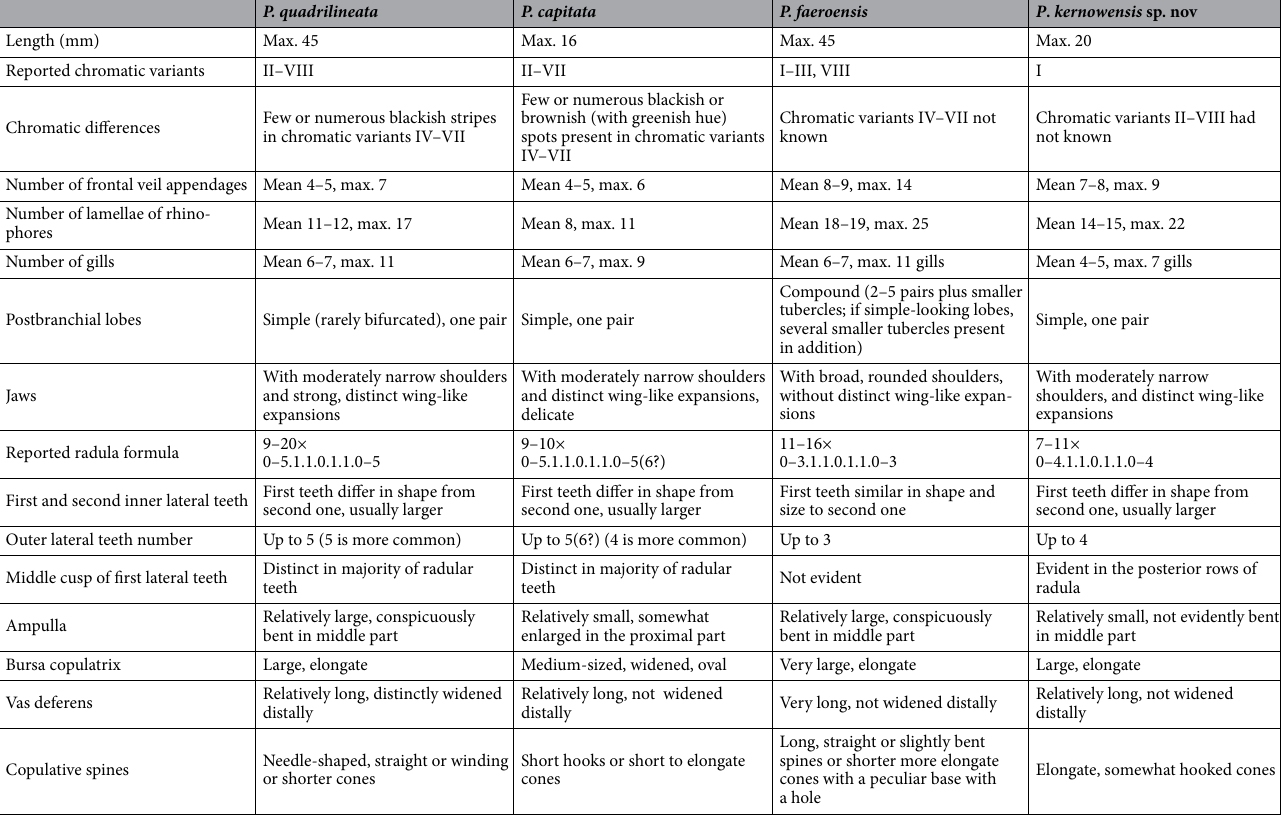
Table 1. Verified and updated comparison of key diagnostic characters of the European Polycera species complex based on the multilevel organismal diversity approach. The characters are given for adults or subadults